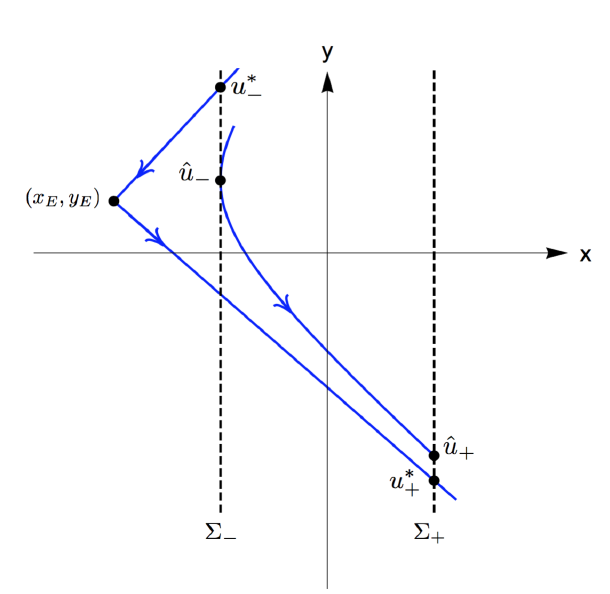
Fig. 3 The saddle point ( x E , y E ) and its invariant manifolds for the upper system ( S U ). Other distinguished values are